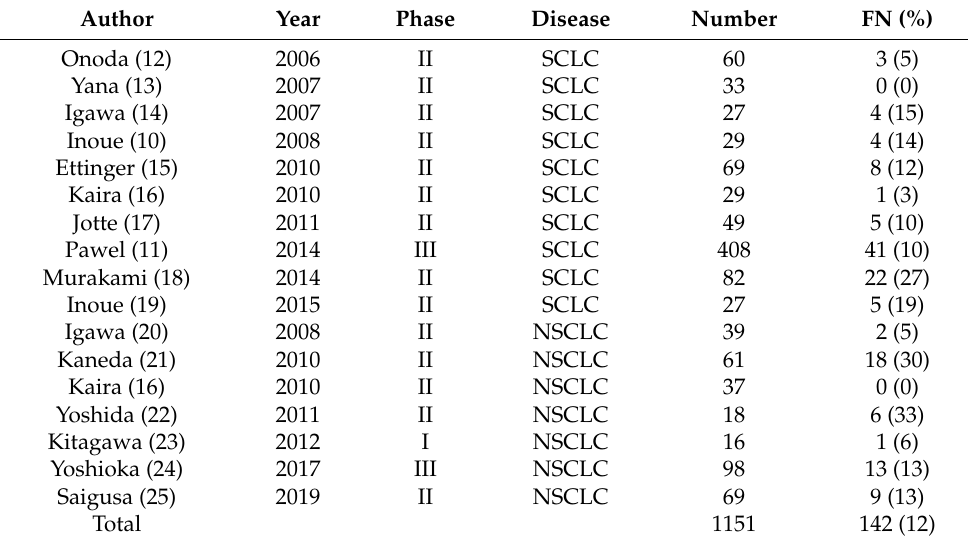
Table 7. Incidence rate of febrile neutropenia after single-agent amrubicin therapy in previous prospective studies ( N = 1151)